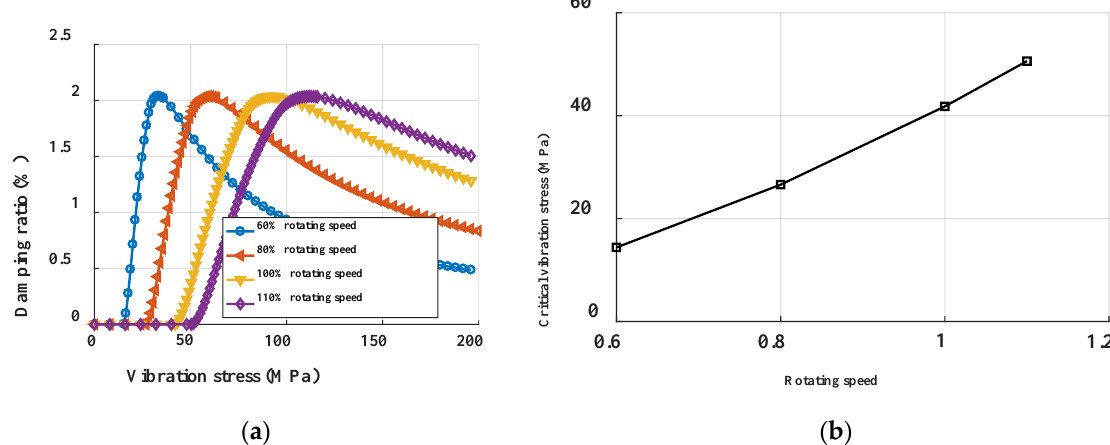
Figure 20. Damping characteristics at different rotating speeds for labyrinth seal: ( a ) DCC; ( b ) Critical vibration stress.